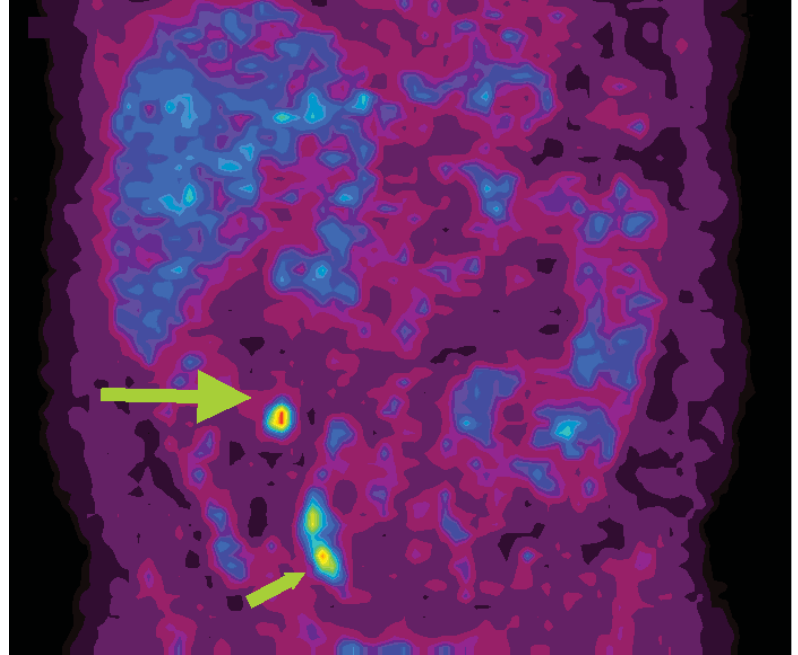
Figure 2. Coronal 11 C-5-HTP PET image of a patient with small intestinal NET (patient 30). A focal high tracer uptake (large arrow) represents a mesenteric lymph node metastasis. Also urinary radioactivity is seen in the right ureter (small arrow).